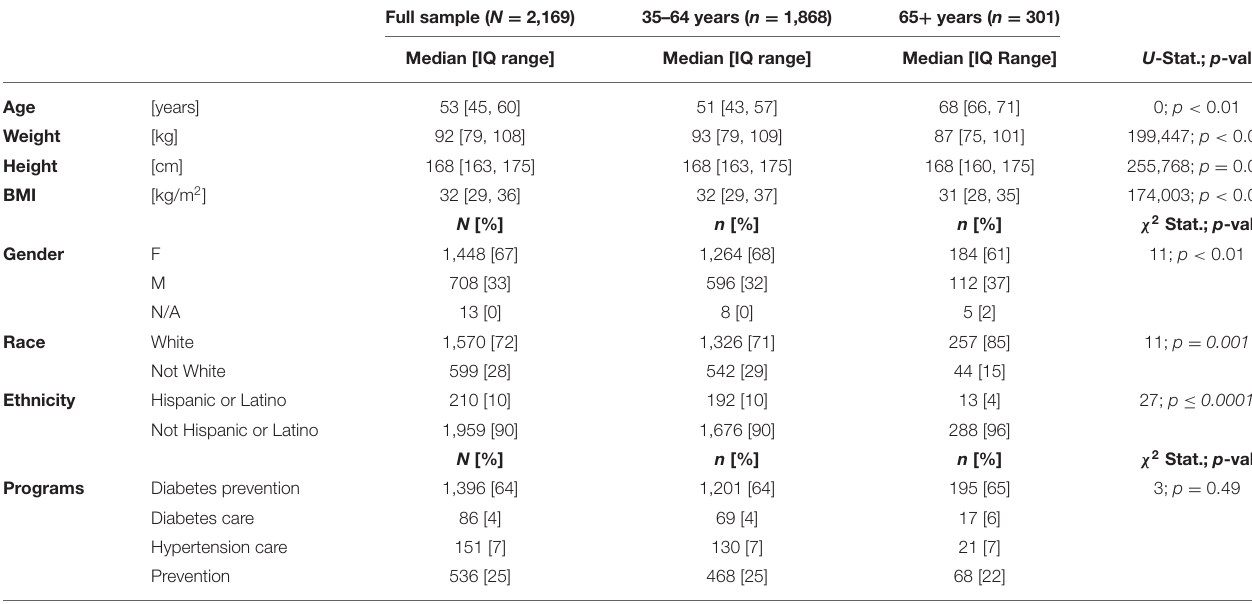
TABLE 1 | Participant demographics and characteristics and distribution of users across programs.